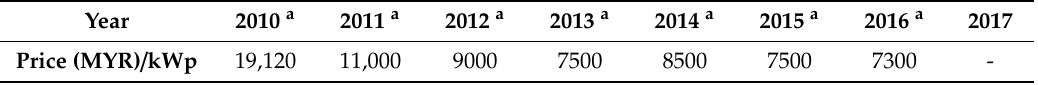
Table 5. National trends in PV-inverter system